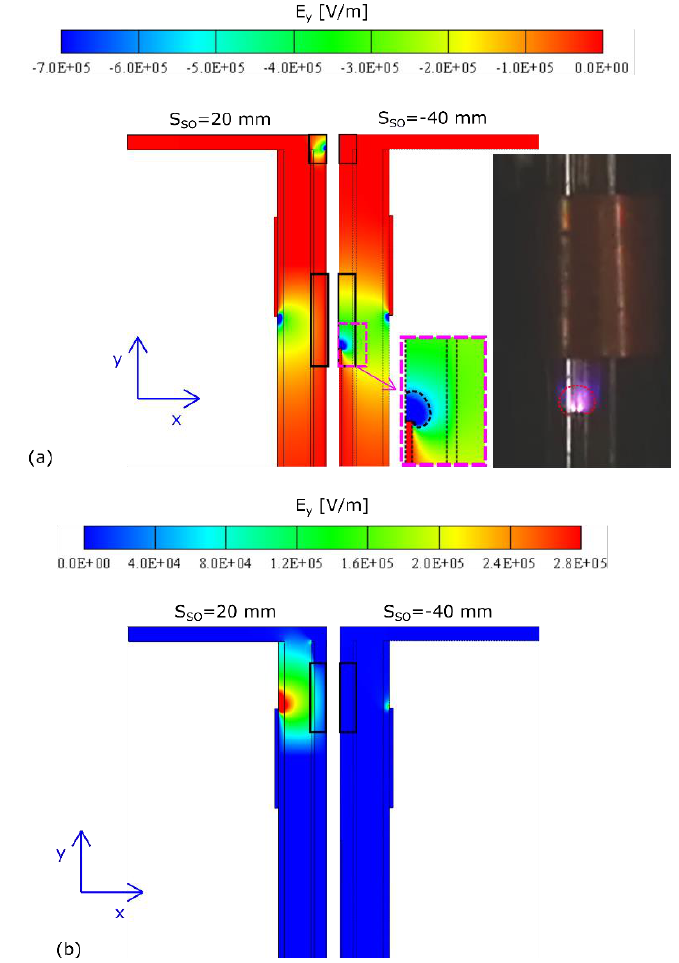
Figure 7. Numerical prediction of the electric field inside the burner for both stand-off configurations under steady-state conditions: ( a ) E y < 0; ( b ) E y > 0. An experimental image of the plasma discharge is also shown in (a). S SO = -40 mm (SIM 1) vs S SO = 20 mm (SIM 2).